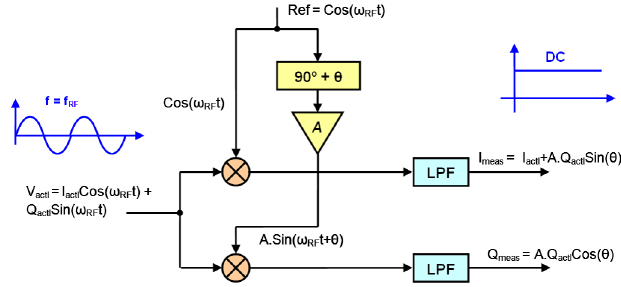
channel.FIG. 2. Simplified block diagram of an analog IQ demodula- tor; A and (cid:3) represent gain and phase imbalances of the Q channel with respect to the I